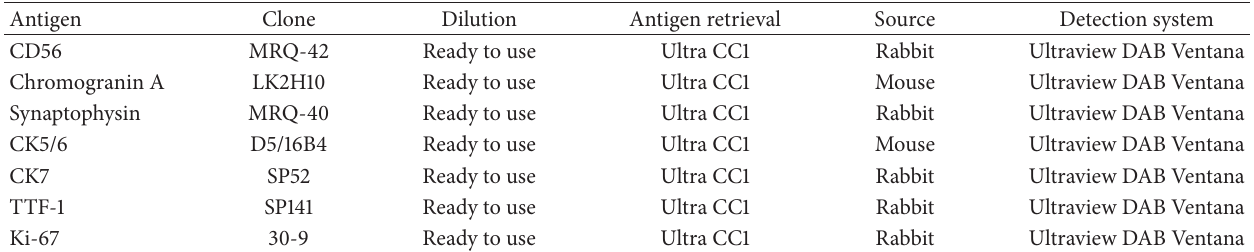
Table 1: Immunohistochemistry: antibodies used on this